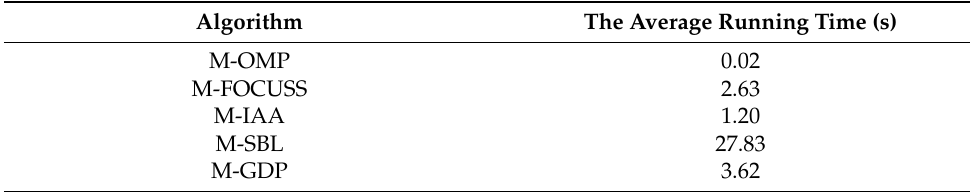
Table 3. The average running time.